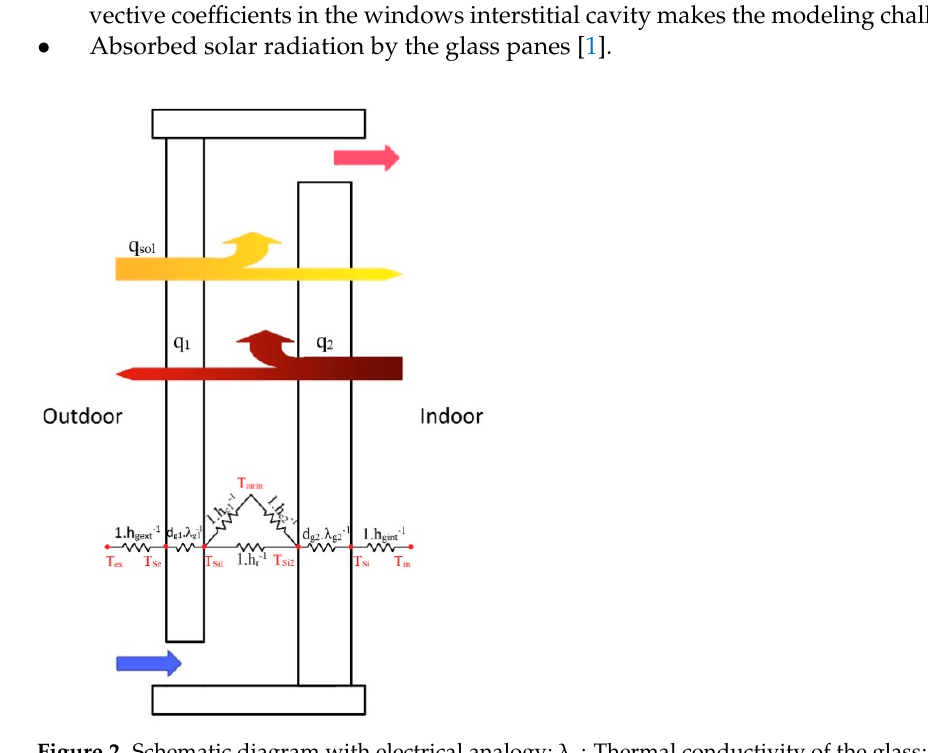
Figure 2. Schematic diagram with electrical analogy; λ g : Thermal conductivity of the glass; T ex : Outdoor temperature; T se : Outdoor surface temperature of glass; T sin : Indoor surface temperature of glass; h r : Radiative heat transfer coefficient; h gext : Heat transfer coefficients (external glazed surfaces); h gint : Heat transfer coefficients (internal glazed surfaces); q sol : Total solar radiation; q: Heat flow; h c : Heat transfer coefficient.